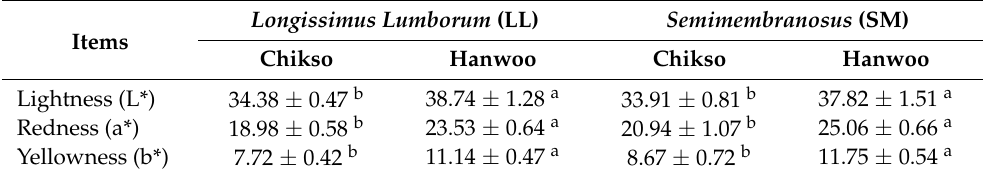
Table 2. Color traits of LL and SM muscles from Chikso and Hanwoo under identical rearing conditions. Longissimus Lumborum (LL) Semimembranosus (SM) Items Chikso Hanwoo Chikso Hanwoo Lightness (L*) 34.38 ± 0.47 b Redness